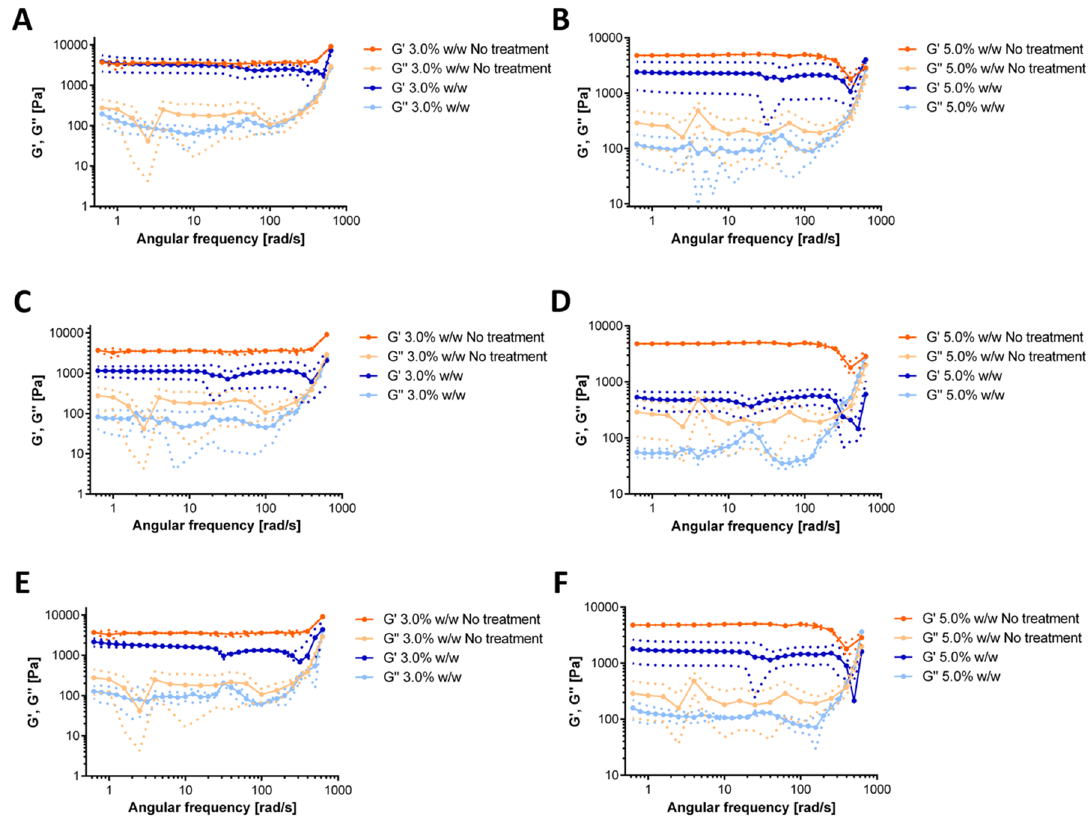
Figure 6. Storage and loss moduli for hydrogels after exposure to gastrointestinal tract simulated media and the comparison with a hydrogel in the absence of the treatment. Saliva simulated medium Figure 3. 0% ( w/w ) ( A ) and 5.0% ( w/w ) ( B ) GTA concentration. Stomach simulated medium for 3.0% ( w/w ) ( C ) and 5.0% ( w/w ) ( D ) GTA concentration. Small Intestine simulated medium for 3.0% ( w/w ) ( E ) and 5.0% ( w/w ) ( F ) GTA concentration.